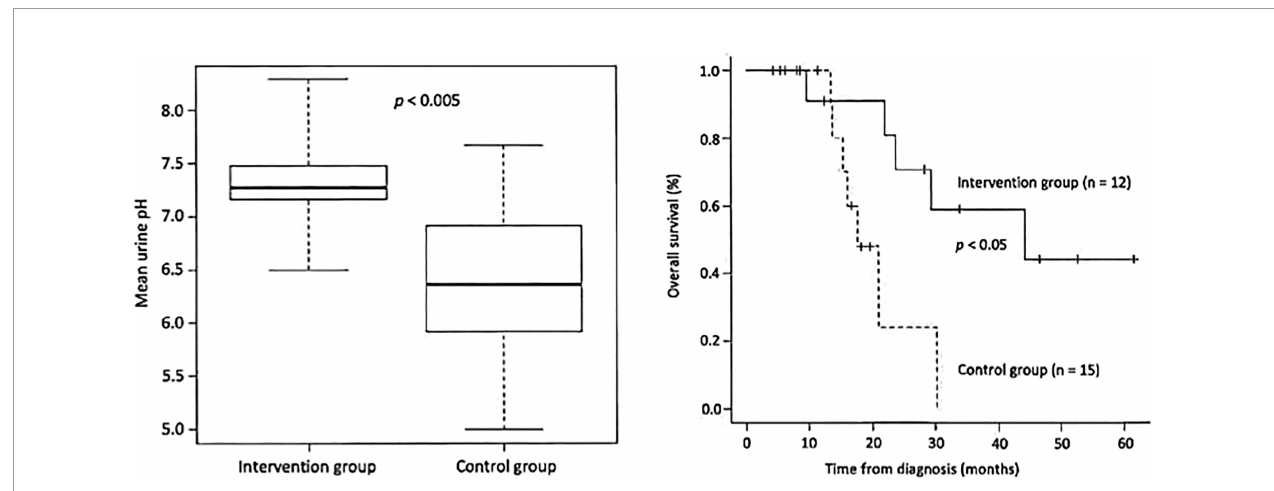
FIGURE 1 | (Left) The mean urine pH of the alkalization group of small cell lung cancer patients is shown to be higher than that of the control group. (Right) The overall survival of the alkalization group of small cell lung cancer patients is shown to be prolonged compared with that of the control